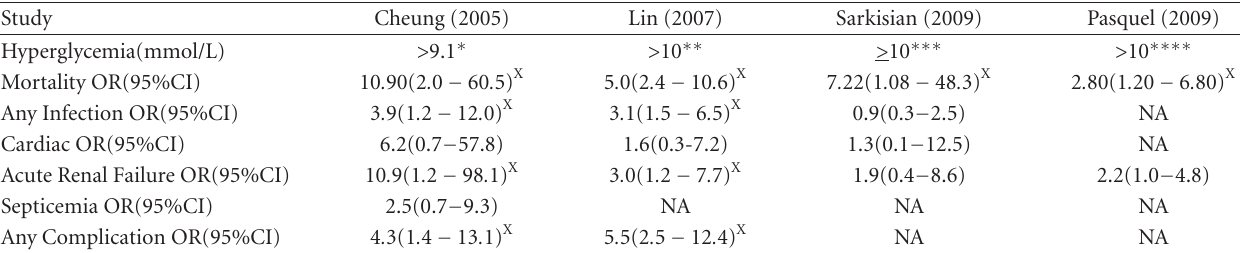
Table 2: Risk of mortality and complications due to hyperglycemia in patients receiving